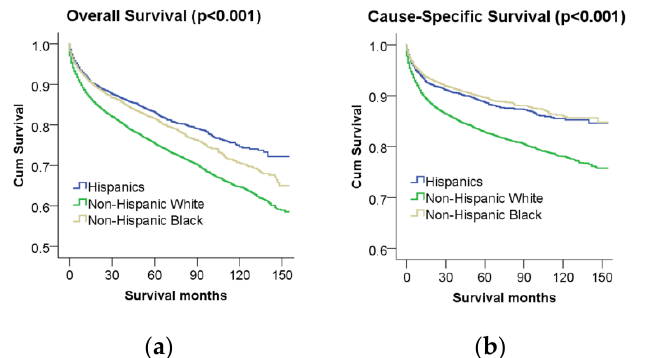
Figure 2. ( a ) Racial disparities in overall survival; ( b ) racial disparities in cause-specific survival. Table 2. Multivariable Cox regression analysis for overall survival and cause-specific survival. OS Multivariable Analysis CSS Multivariable Analysis Characteristics HR (95% CI) p- Value HR (95% CI) p- Value